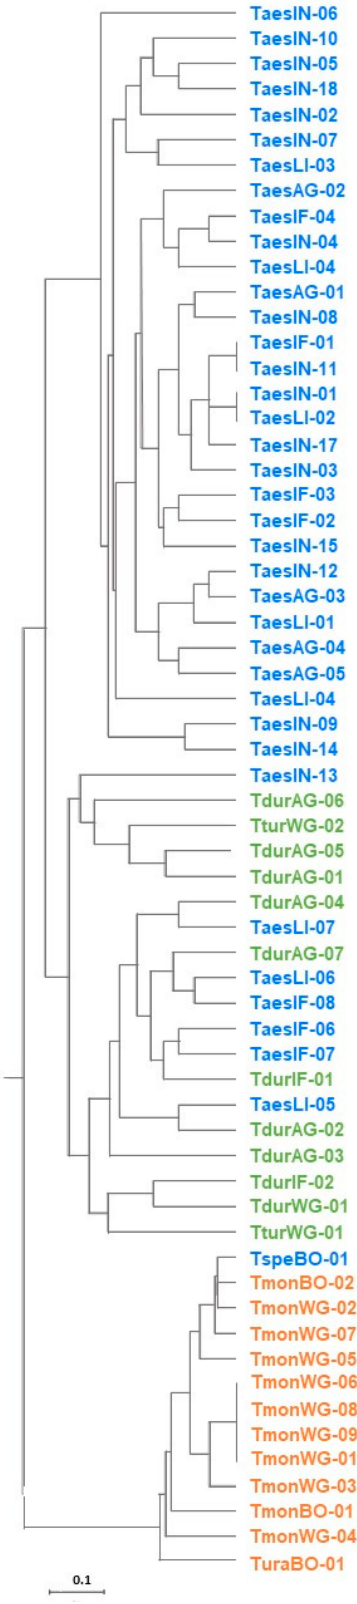
Figure 7. Phylogenetic unweighted pair group method with arithmetic mean (UPGMA) tree showing the relationships among 62 wheat lines genotyped with 13 ISBP markers. Triticum aestivum lines are shown in in blue, T. durum and T. dicoccoides in green, and T. monococcum in orange.